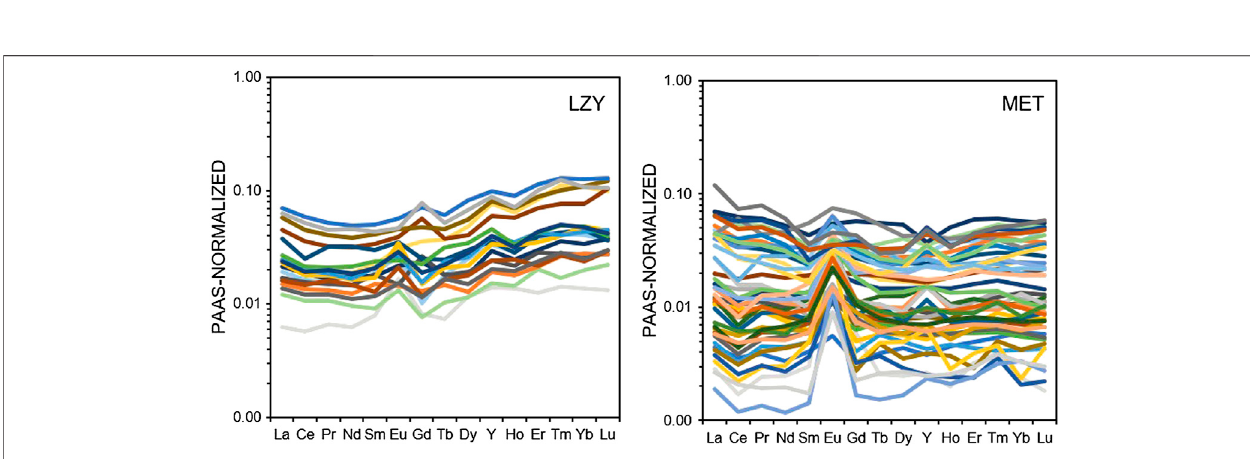
Frontiers in Earth Science |